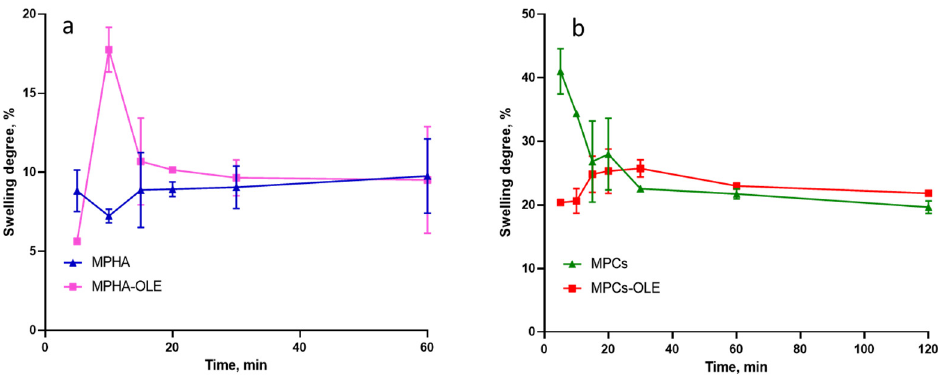
Figure 5. Swelling curves of ( a ) MPHA and MPHA-OLE and ( b ) MPCs and MPCs-OLE in pseudo extracellular fluid (PECF) at 37 °C. Means ± SD ( n = 3).